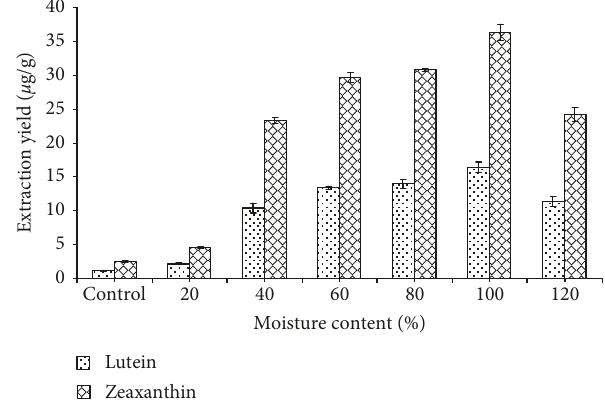
Figure 3: Effect of moisture content on extraction yields of carotenoids.